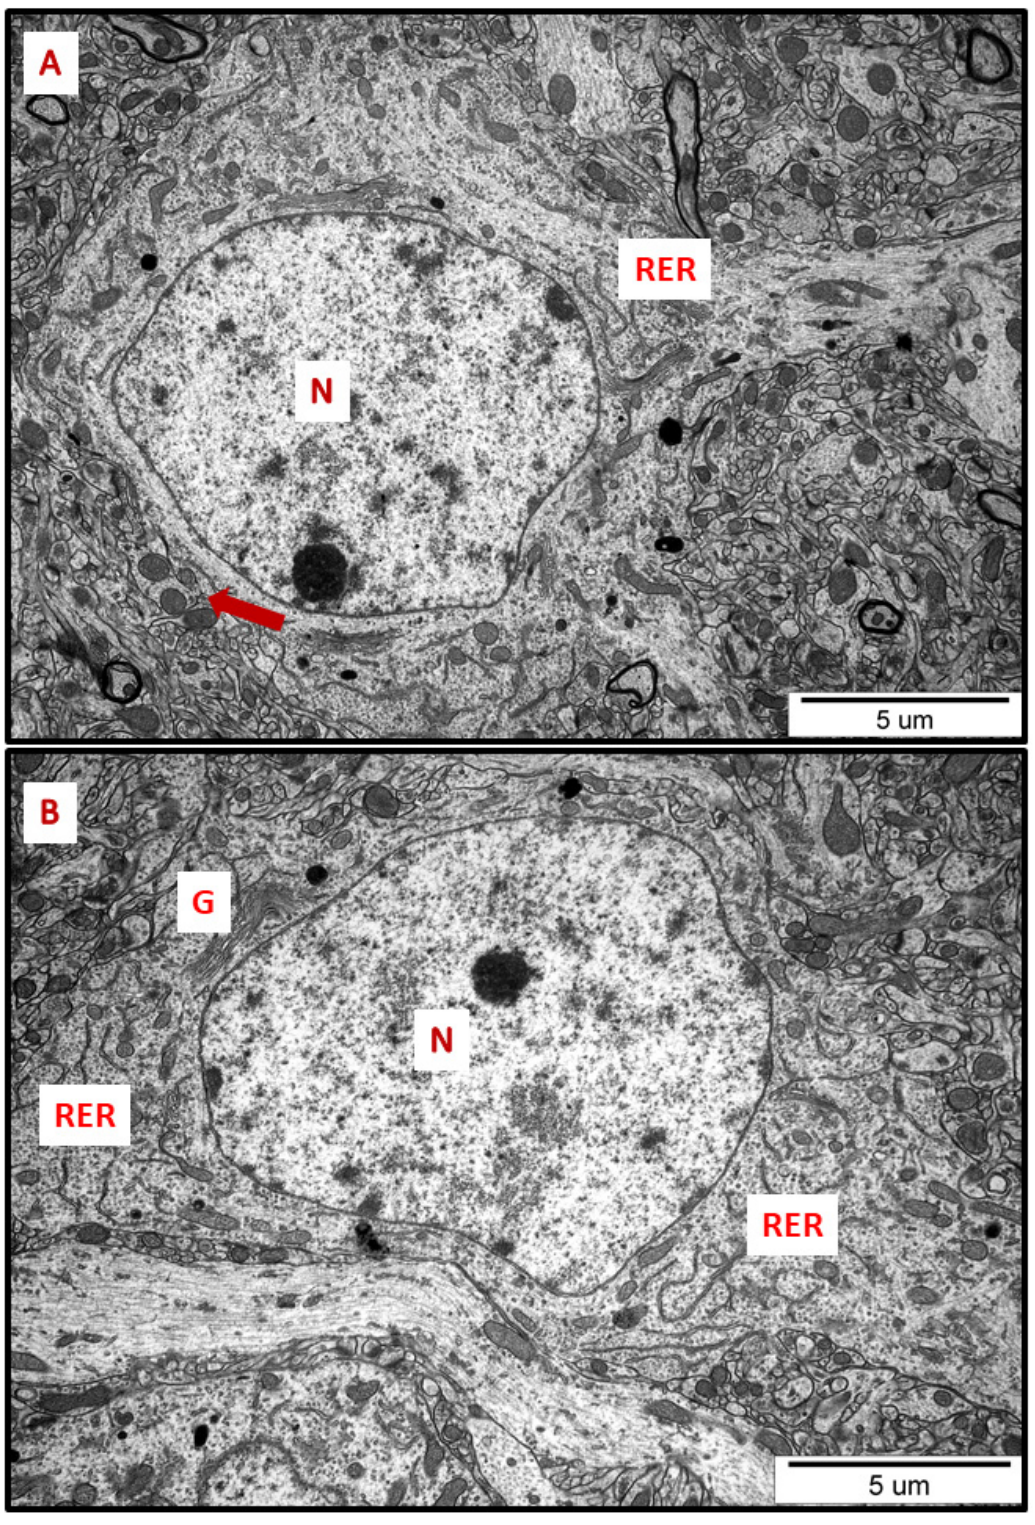
Figure 1. Representative TEM micrographs of cerebral ( A ) and hippocampal ( B ) sections from control animals. Normal ultrastructure of neurons is visible; RER—rough endoplasmic reticulum; N— nucleus; Golgi apparatus (G); mitochondria (arrows). Images are typical for each of the 3 examined animals per group.